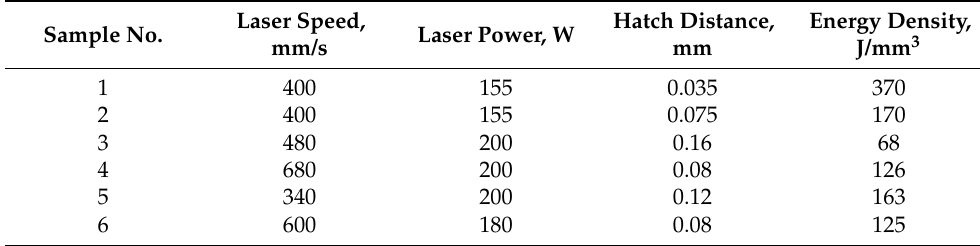
Table 2. The six sample conditions chosen for the LPBF process, in which the h -layer thickness is kept constant at 30 µ